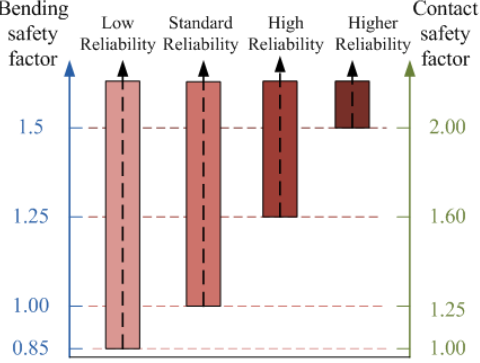
Figure 1. The ranges of two safety factors in each gear